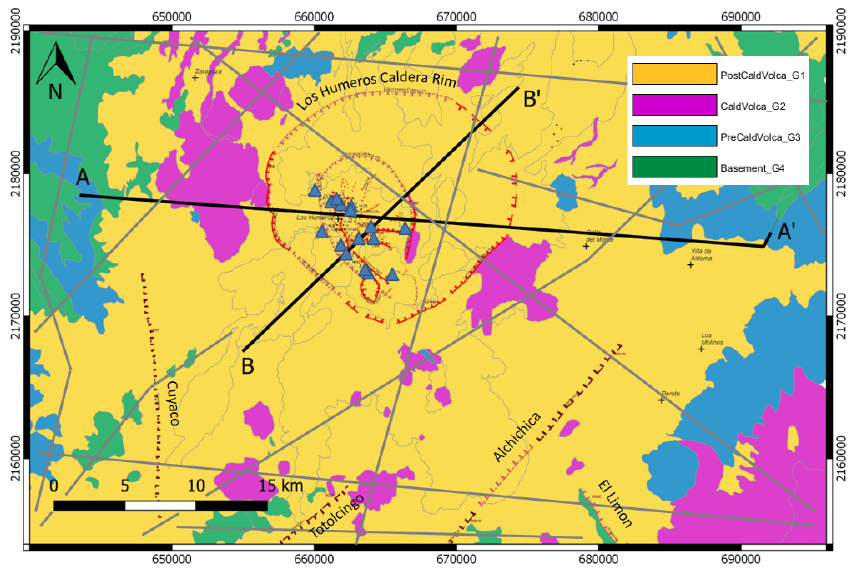
Figure 5. Los Humeros geological map reinterpreted from Carrasco-Núñez et al. (2017b) using the four groups selected for the regional scale modelling. Blue triangles: location of the sixteen wells used for modelling. AA’: Carrasco-Núñez et al. (2017a) cross-section trace, BB’: Norini et al. (2015) cross-section trace (see Fig. 8). Dark grey traces: additional cross-sections interpreted for constraining the model. Coordinate system is WGS84/UTM zone